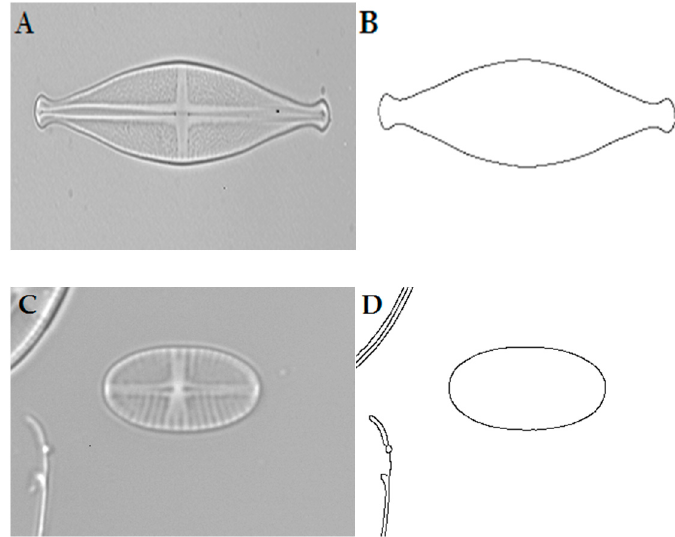
Figure 4. Results obtained with the Canny edge detector. ( A ) Original image. ( B ) Results obtained with three different set of parameters [h min , h max , σ ]: [0.095, 1.0, 0.1], [0.095, 1.0, 0.3], [0.15, 1.0, 0.9]. ( C ) Original image. ( D ) Results obtained with [h min , h max , σ ]: [0.15, 0.6, 0.7], [0.15, 0.5, 0.7], [0.15, 0.7, 0.9]. Only one result is reproduced given that they are almost identical.